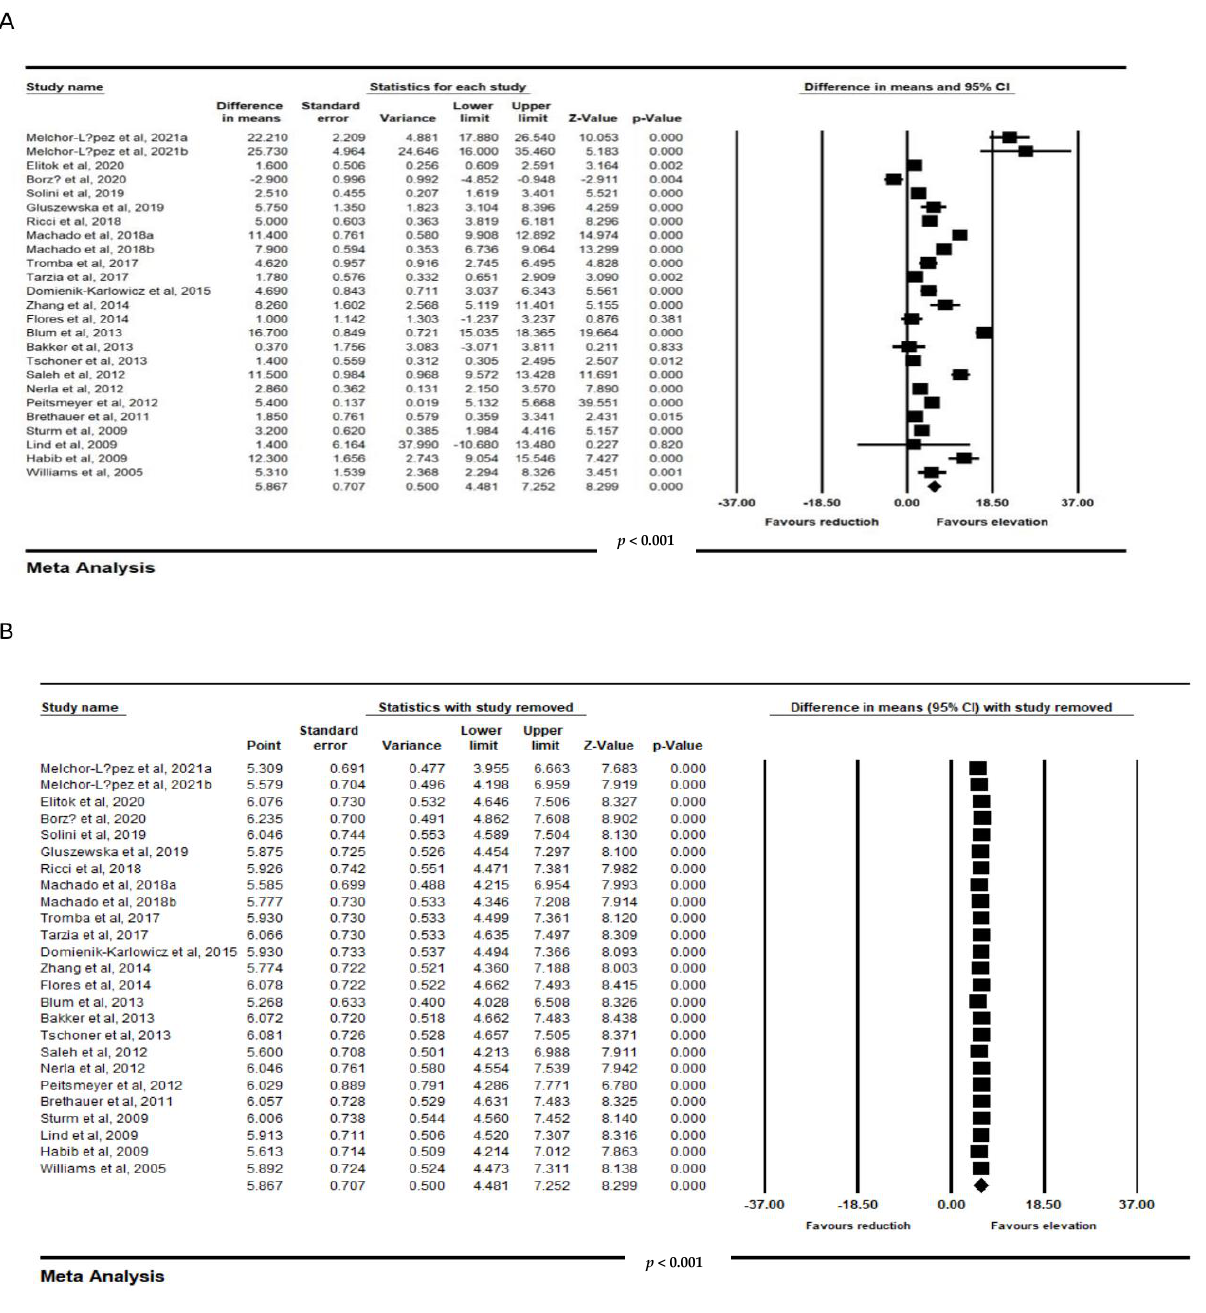
Figure 3. ( A ). Forest plot displaying standardized mean difference and 95% confidence intervals showing the consequence of bariatric surgery on FMD. ( B ). Leave-one-out sensitivity analyses indicating the consequence of bariatric surgery on FMD (891 subjects).